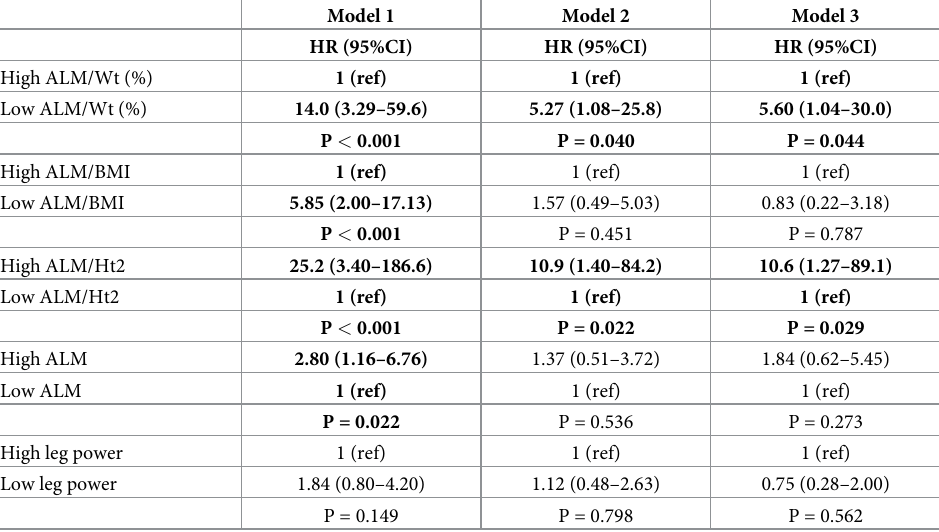
Table 4. Association between baseline ALM indices or leg muscle power and incidence of metabolic syndrome (Cox model) (N =